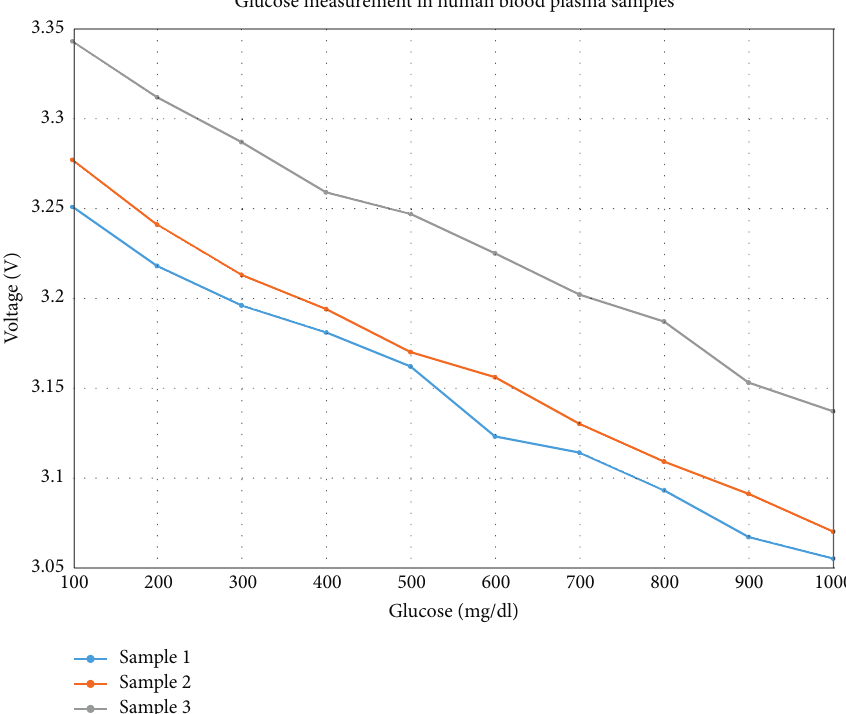
Figure 10: Glucose measurement in human blood plasma solutions.